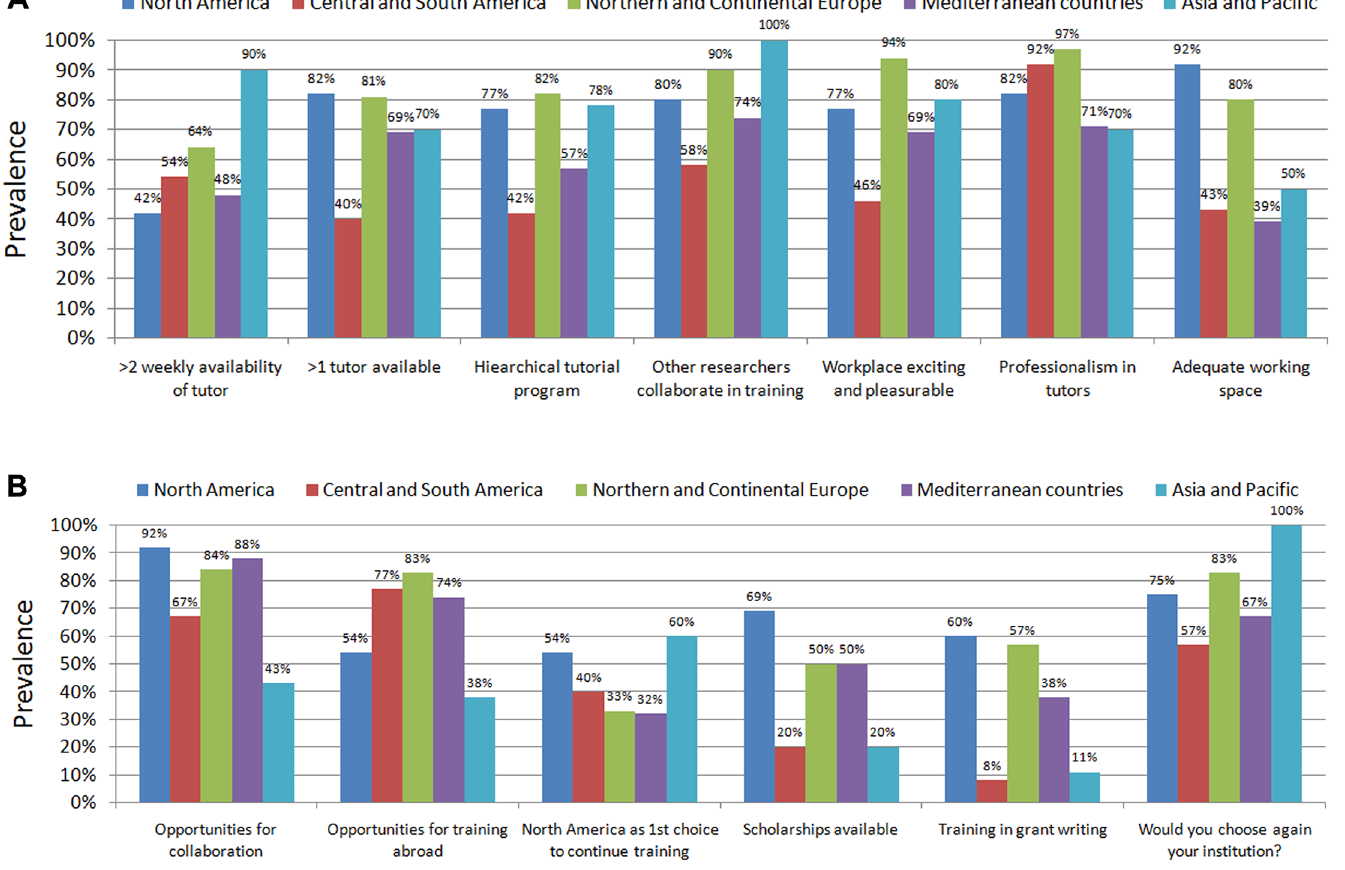
Fig 2. Key differences in replies according to geographic area of origin of respondents (panel A and panel B).